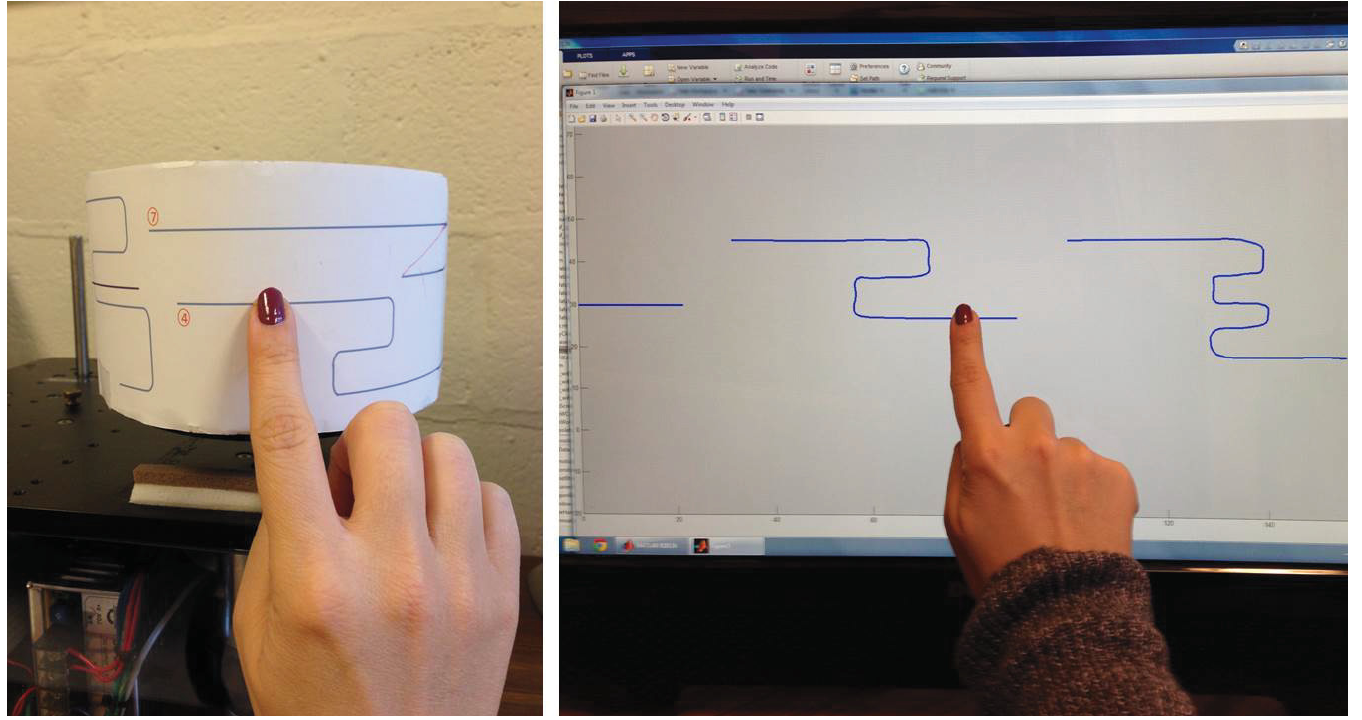
Fig 1. Experimental Setups for ME and TE. Picture depicts the research personnel tracking the curves presented on the surface of the rotating wheel (on the left picture) and on the touchscreen monitor (on the right picture).